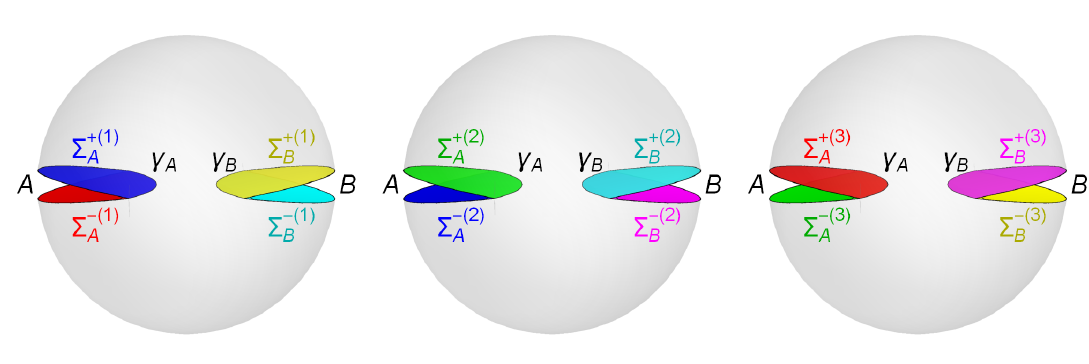
Figure 3 . The topology of a replica symmetric saddle contributing to the holographic Rényi negativity N k for k = 3 . The three replicas are first cut along Σ A , Σ B , and then the cut surfaces Σ ± ( i ) , Σ ± ( i ) , i = 1 , . . . , 3 with the same color are glued together (cyclically along Σ A and anti- A B cyclically along Σ B